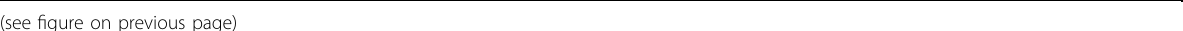
Fig. 5 Circ-HMGA2 acts as a sponge for miR-1236-3p. A Analysis of the miRanda database indicated that circ-HMGA2 contains a binding site for miR-1236-3p. B The relative expression levels of miR-1236-3p in LUAD tissues and adjacent normal tissues were determined by qRT-PCR. C Transwell assays were performed in H1299 and A549 cells after transfection of the miR-1236-3p inhibitor. Scale bar: 200 μ m. D miR-1236-3p inhibited EMT progression in LUAD cells. E Schematic illustration of circ-HMGA2 luciferase reporter vectors containing the wild-type (WT) or mutant (Mut) putative miR-1236-3p binding sites. F Luciferase activity was analyzed in 293T cells after co-transfection with miR-1236-3p mimics, miR-NC or miR-1236-3p inhibitors, and the WT or Mut luciferase reporter vectors. The relative luciferase activity was presented by the relative hRluc/hluc ratio. G The FISH results showed that circ-HMGA2 and miR-1236-3p are co-localized in the cytoplasm. Scale bar: 8 μ m. * P < 0.05, ** P <